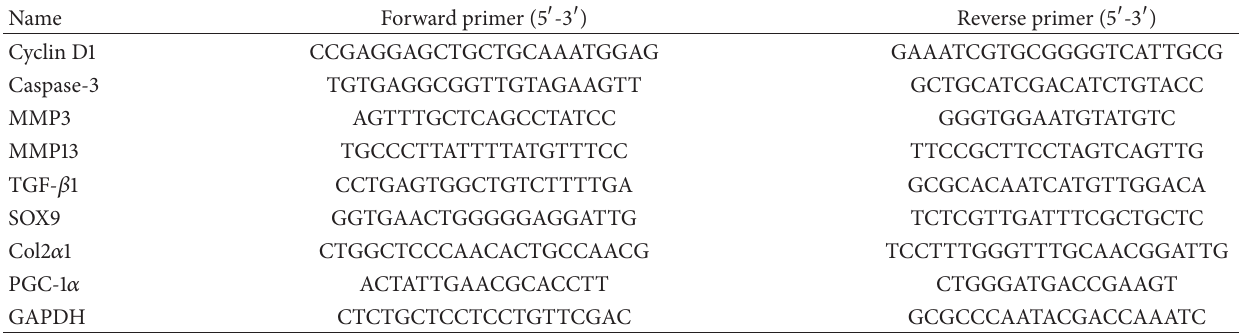
Table 1: The primer sequences for detection of gene